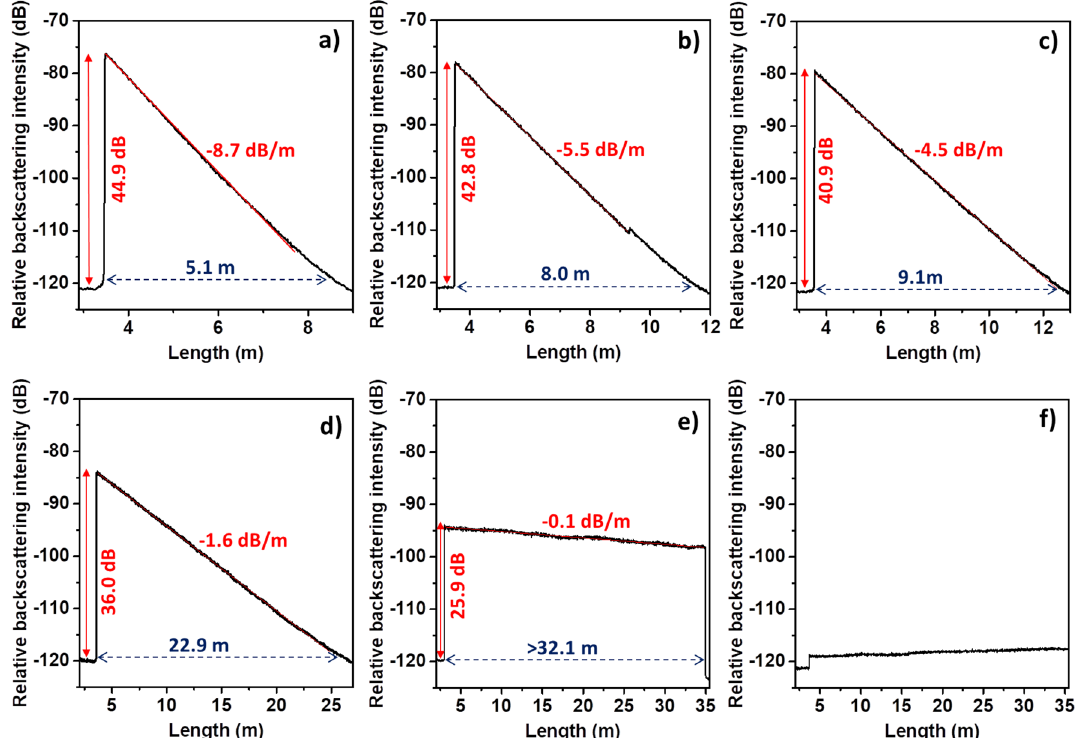
Figure 3. Backscattered intensity vs fiber length for Ca-based nanoparticles doped fibers drawn at different temperatures: ( a ) 1870 °C, ( b ) 1890 °C, ( c ) 1955 °C, ( d ) 2020 °C, ( e ) 2065 °C and ( f ) 2100 °C. No backscattering enhancement was observed in fibers drawn at temperatures higher than 2100